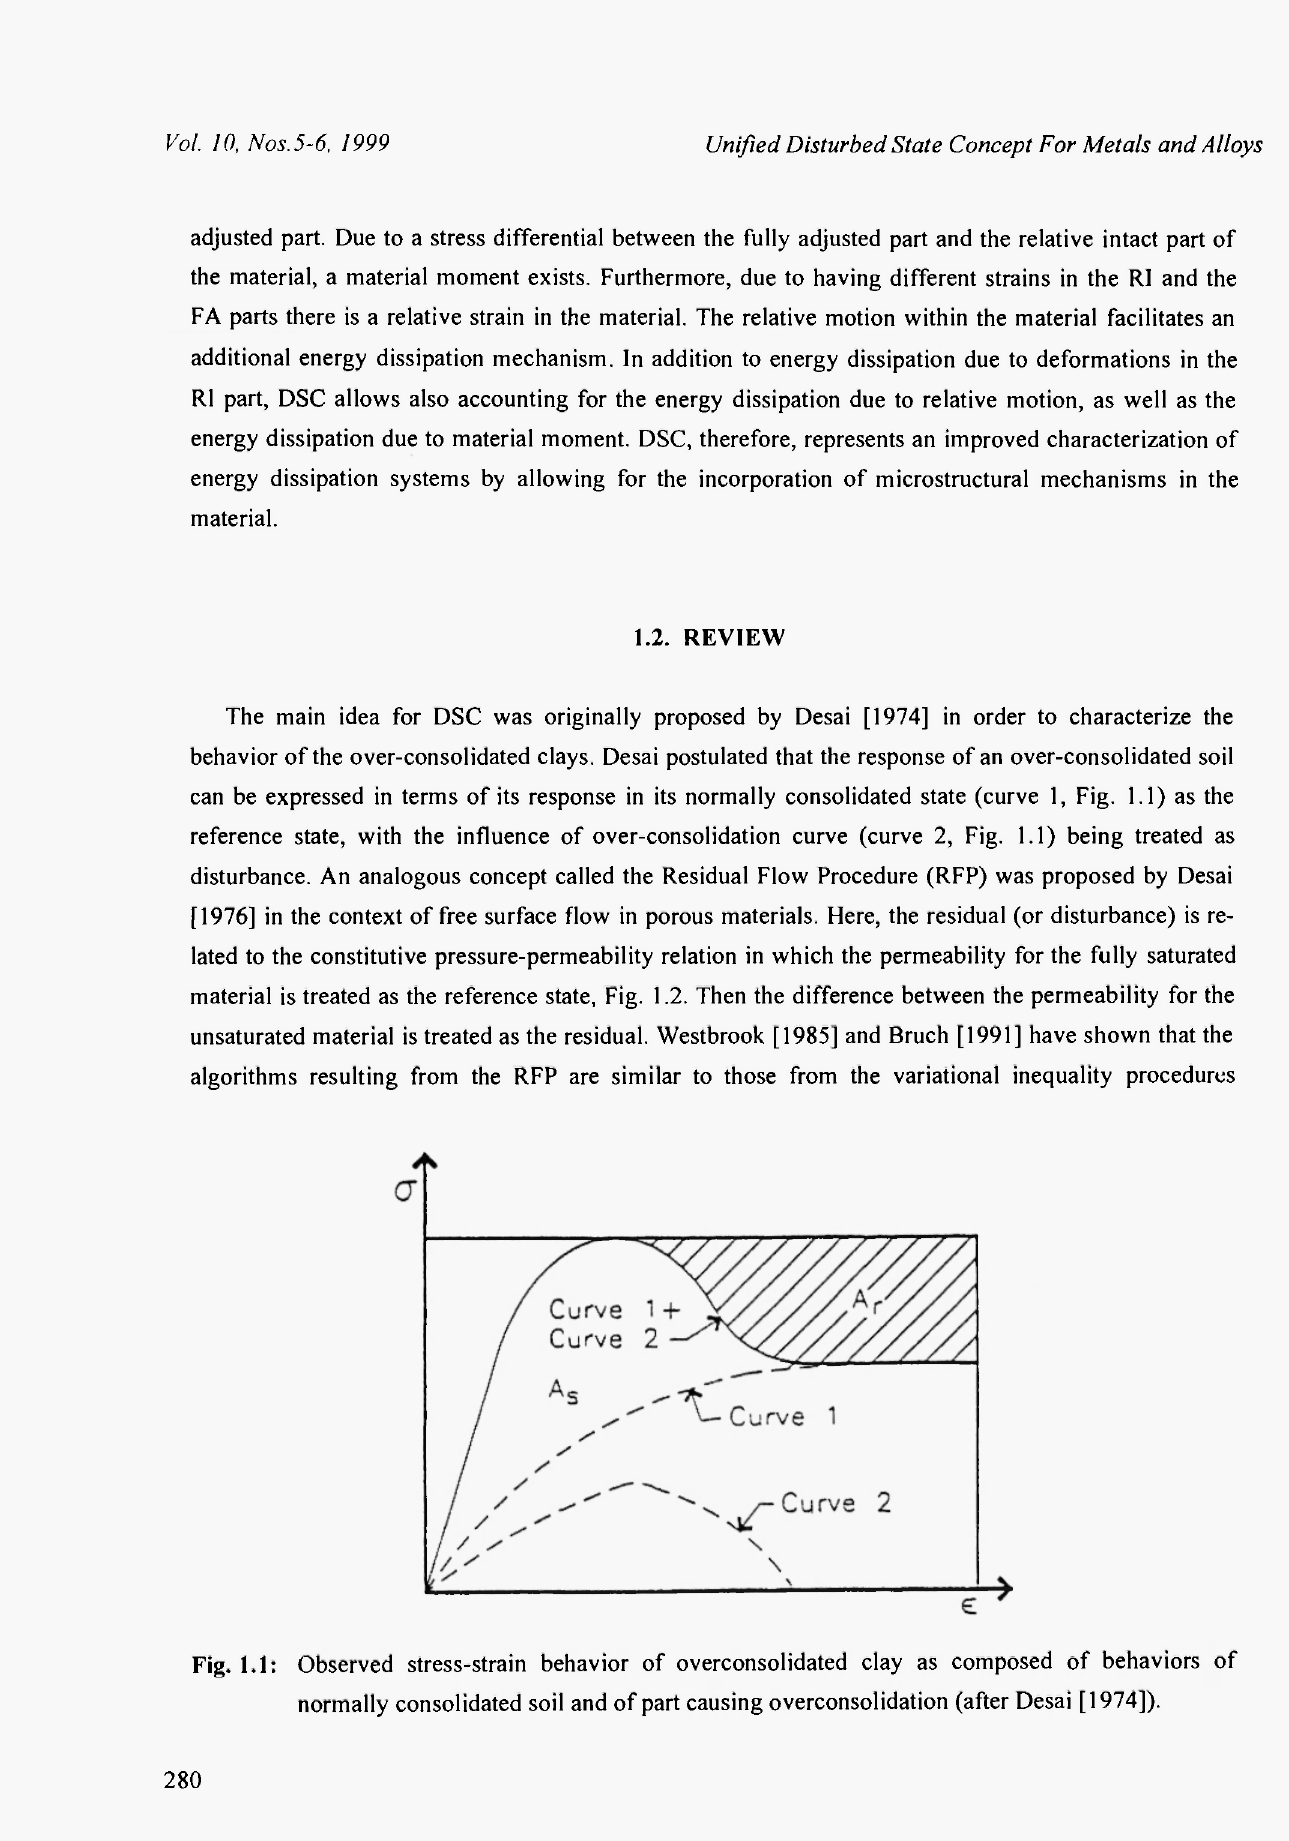
Fig. 1.1: Observed stress-strain behavior of overconsolidated clay as composed of behaviors of normally consolidated soil and of part causing overconsolidation (after Desai